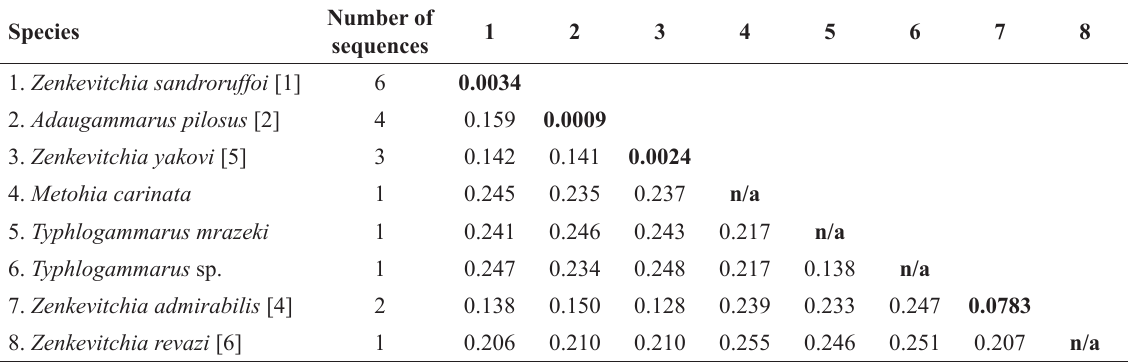
Table 2. Estimates of pairwise sequence divergence (uncorrected p-distances) of partial mitochondrial COI gene among and within species (bold type) of the Balkan and Caucasian Typhlogammaridae. Numbers in brackets correspond to geographic locality on Fig. 1; n/a = not